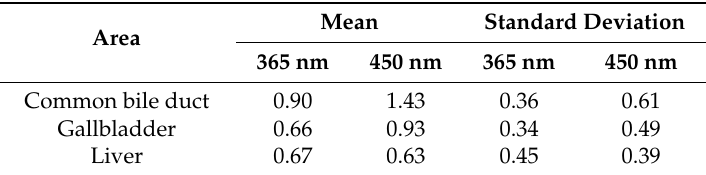
Table 1. Averaged fluorescence intensity maxima.